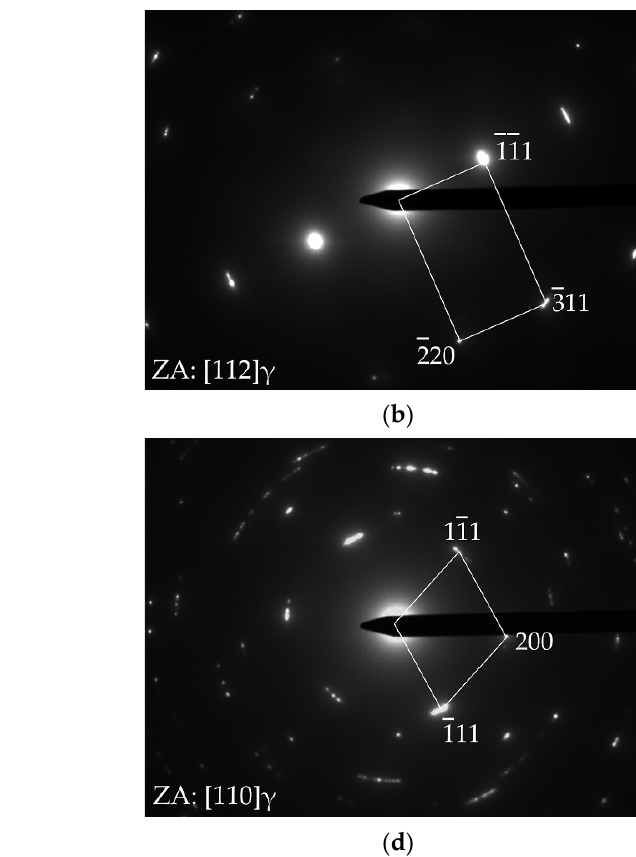
Figure 2. SEM Electron backscatter diffraction (EBSD) images of the steel solution-treated micro- structure. Phase map, where austenite is in blue color, carbides is in red color, high-angle, and twin boundaries are denoted by black and red lines, respectively ( a , e ); orientation map ( b , f ), grain miso- rientation distribution ( c ), grain sizes distribution ( d ). The arrows indicate fine and coarse carbides of MX type ( e ) and annealing twins ( f ).